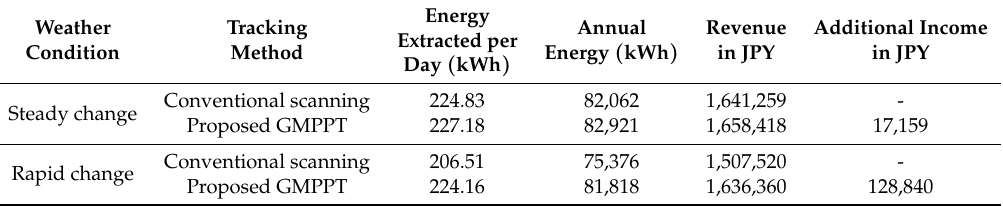
Table 5. Performance comparison and revenue of scanning and proposed GMPPT algorithm using long-term